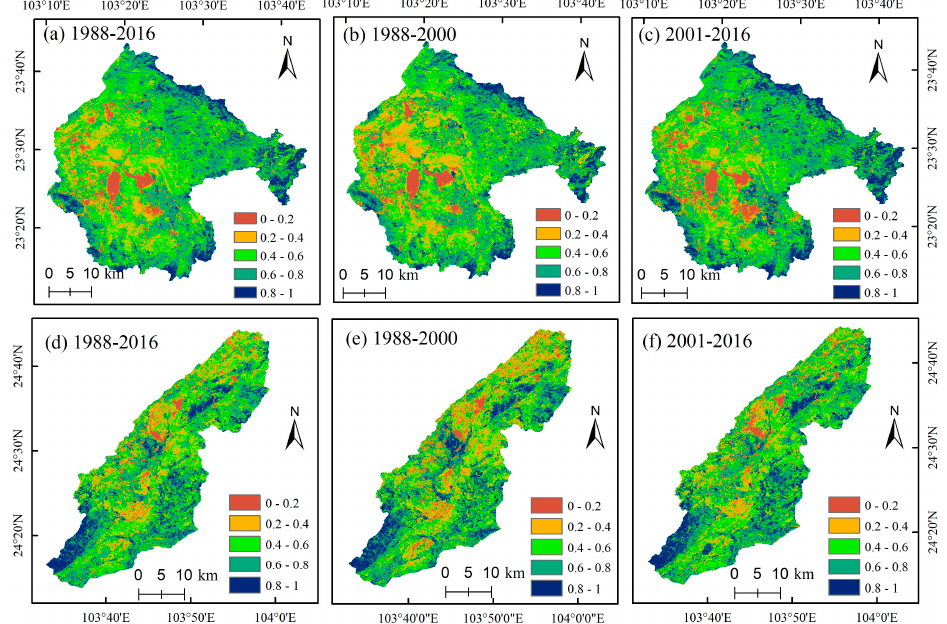
Figure 4. Spatial distribution of average annual fractional vegetation cover (annFVC) for di ff erent time periods. Top row is the Nandong watershed: ( a ) Full time series (1988–2016); ( b ) reference